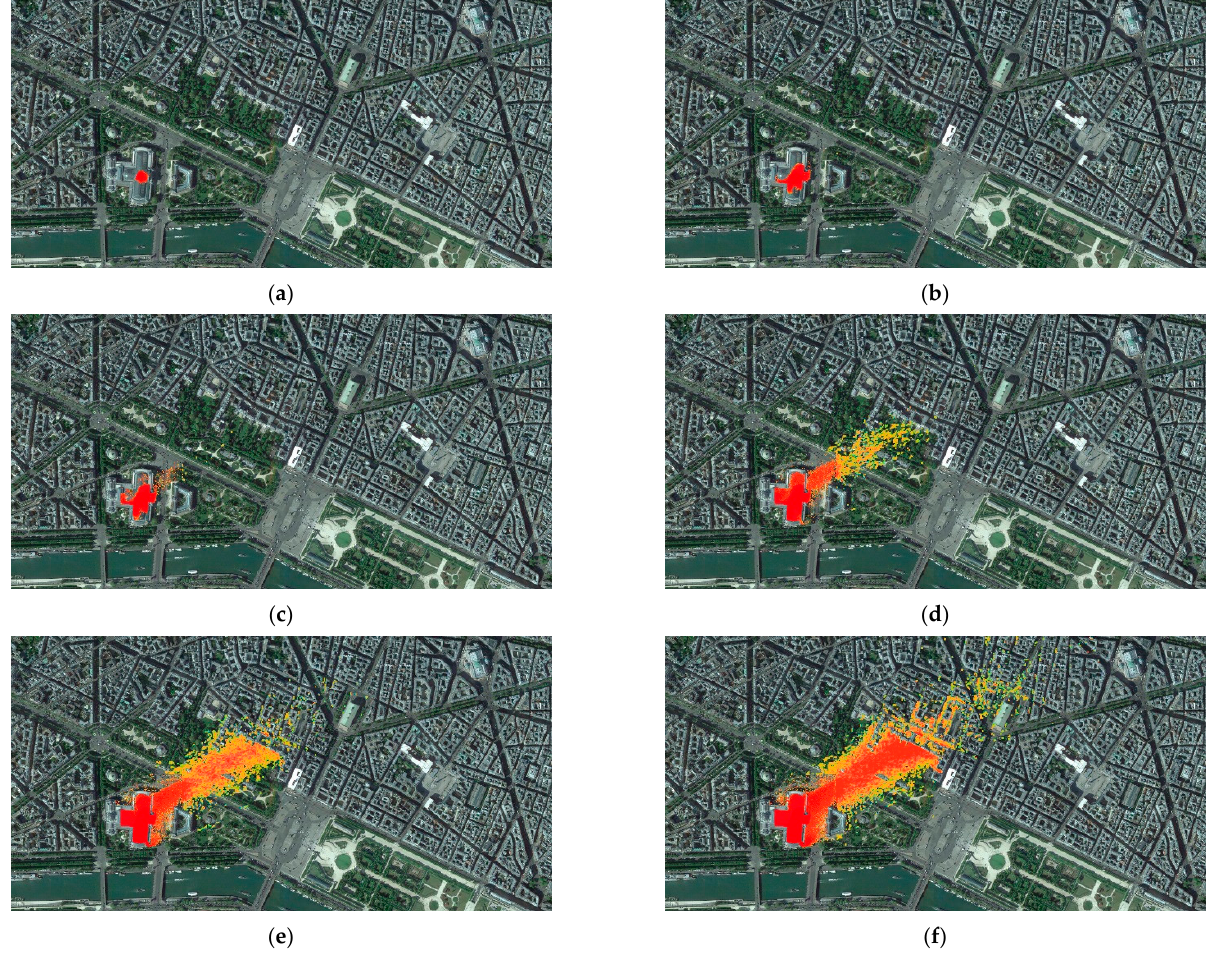
Figure 8. View of the plume inside and in the vicinity of the museum: ( a ) 1 min after the release; ( b ) 3 min; ( c ) 4 min; ( d ) 6 min ( e ) 8 min; ( f ) 10 min. The change from the 1 m resolution of the inner domain to the 3 m resolution of the large domain can be noticed. The threshold for 500 µg/m 3 of concentration is in red, while that for 1 µg/m 3 is in orange and that for 0.001 µg/m 3 is in green.